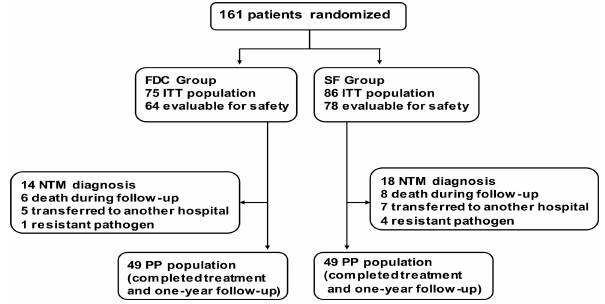
Figure 1 - Study profile. ITT=intent-to-treat; PP=per-protocol; NTM=non-tuberculous mycobacteria; FDC=fixed-dose combina- tion; SF=separate formulation